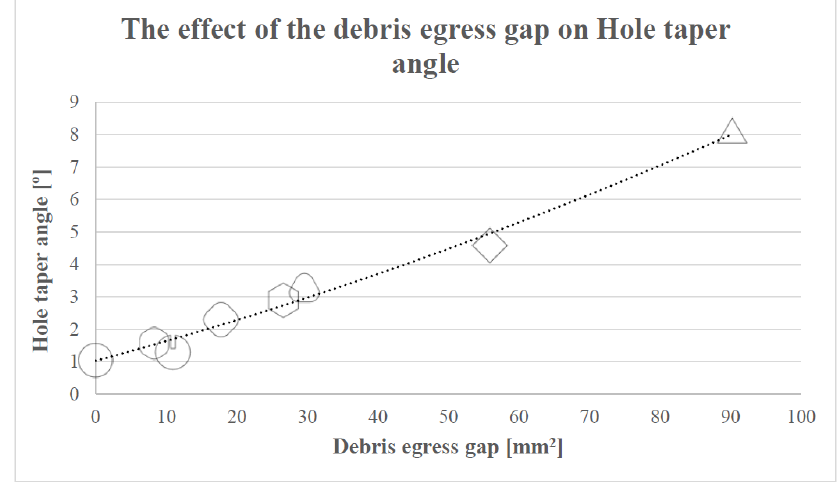
Figure 11. The relationship between the hole taper angle and the debris egress gap.